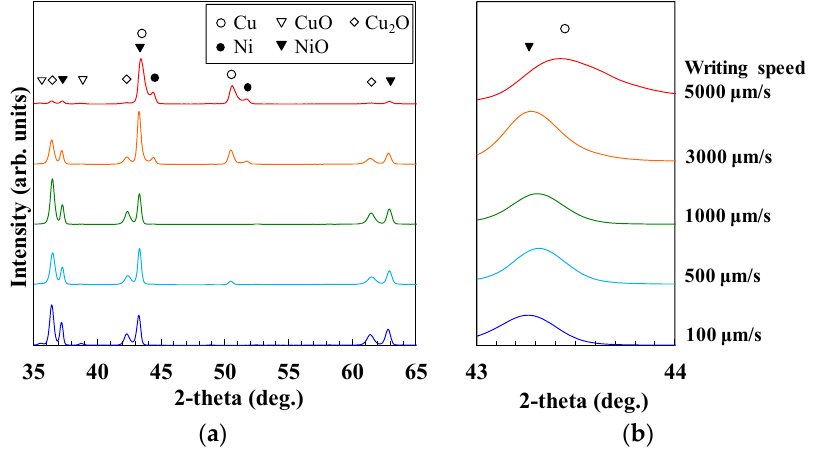
Figure 2. ( a ) X-ray diffraction (XRD) spectra of micropatterns, ( b ) enlargement of these spectra from 43–44 degrees.